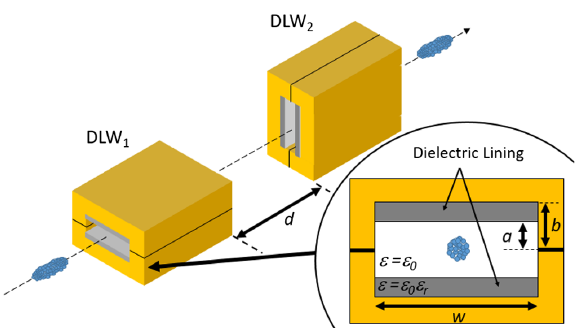
FIG. 1. Schematic diagram of the rectangular dielectric-lined waveguide (DLW) structure and the alternating orientation of two waveguides used for staged acceleration with separation d . The DLWs were designed for synchronism to relativistic electrons therefore, operating at 0.465 THz with a ¼ 250 μ m, b ¼ 300 μ m and w ¼ 1 . 2 mm. The permittivity of the vacuum and dielectric FIG. 2. Dispersion plot for LSM 11 mode synchronous to a ≈ c slab are denoted by ϵ 0 and ϵ relativistic electron beam ( v , respectively. r p